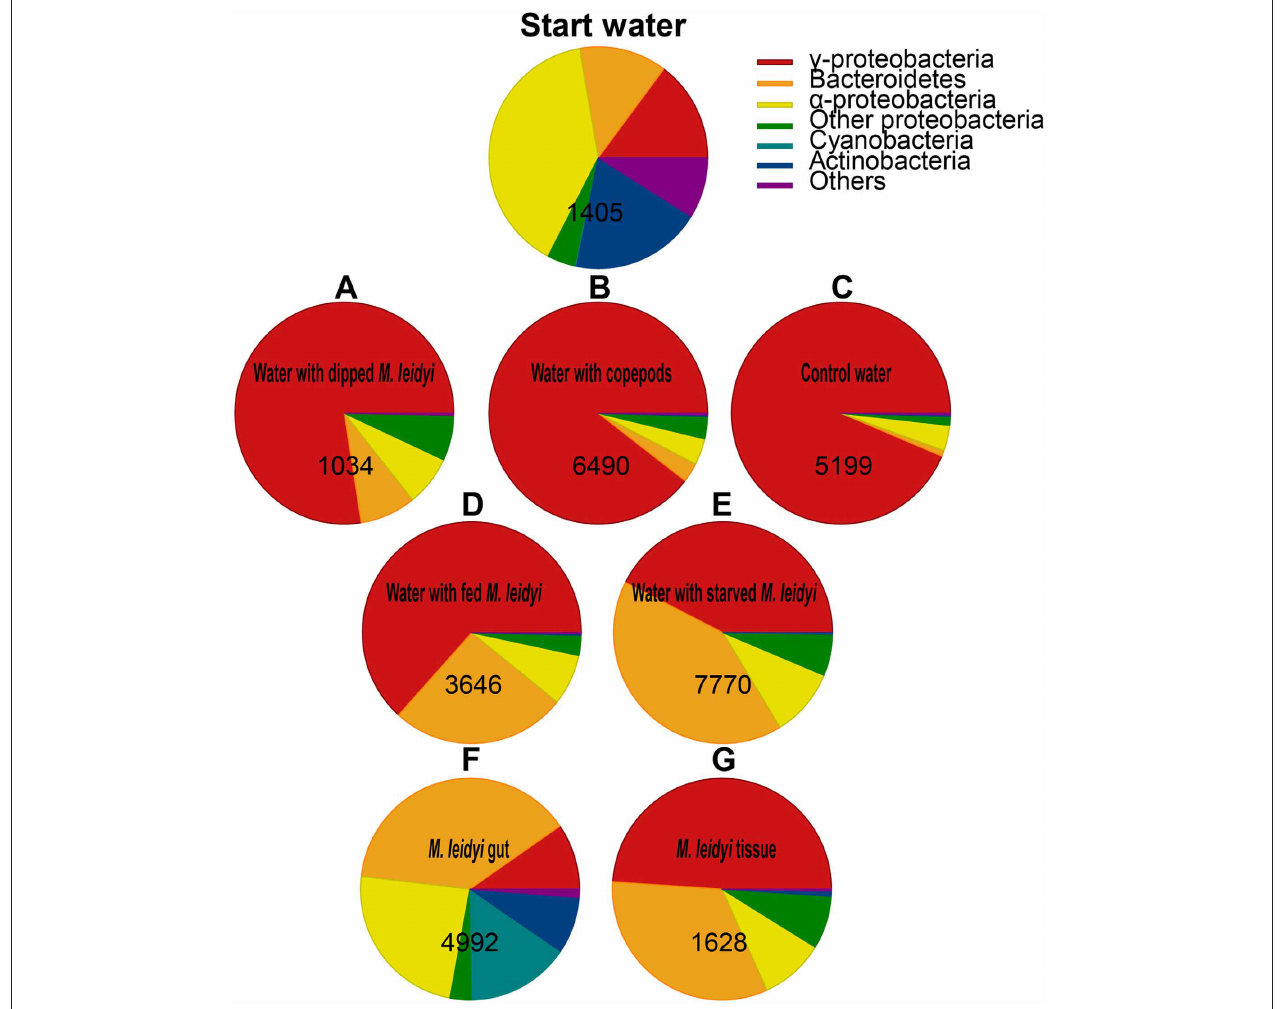
FIGURE 3 | Relative abundance of the major phyla and proteobacterial sub-classes expressed as the % of total sequences obtained from the sample. Numbers indicate the total number of sequences per sample. “Others” represent phyla with < 1% of relative abundance. Control treatments: water with dipped M. leidyi (A) water with copepods (B) and control water (C) . Water treatments with M. leidyi : fed (D) and starved (E) . M. leidyi gut (F) and tissue (G)